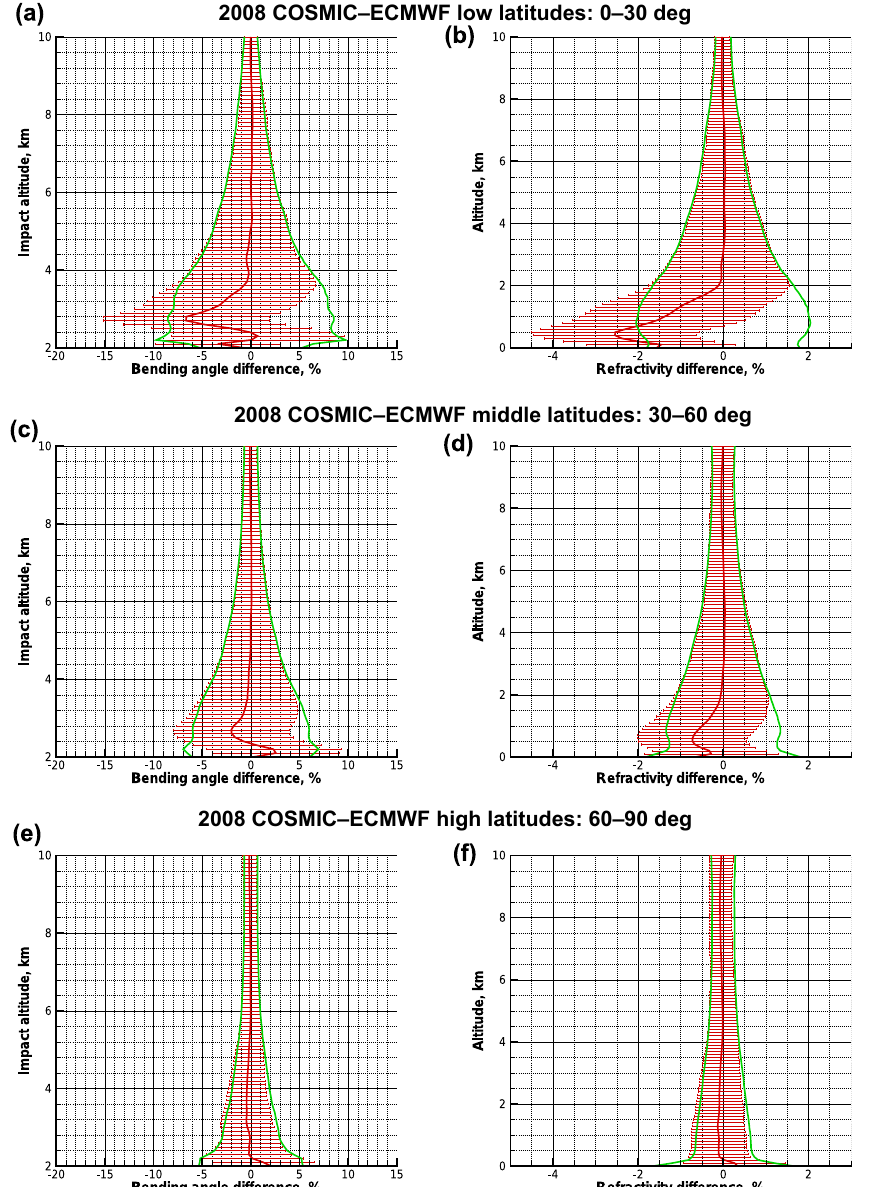
Figure 2. Deviation statistics obtained for real RO data: difference statistics of COSMIC profiles including real fluctuations relative to ECMWF profiles without fluctuations for bending angle as function of impact altitude (a, c, e) and refractivity as function of altitude (b, d, f) , with the same style of panels as for the difference statistics in Fig. 1. Results for low latitudes (a, b) , midlatitudes (c, d) , and high latitudes (e, f) are shown for COSMIC events and concurrent ECMWF analysis fields from the 15th day of every month of year